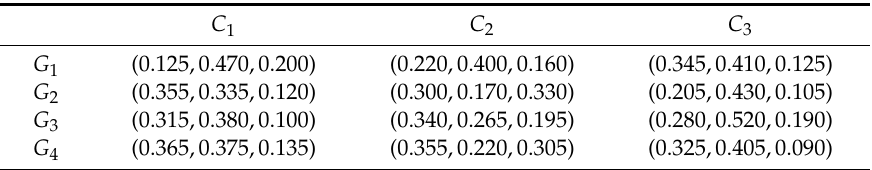
Table 9. Air quality data from station O 2 .